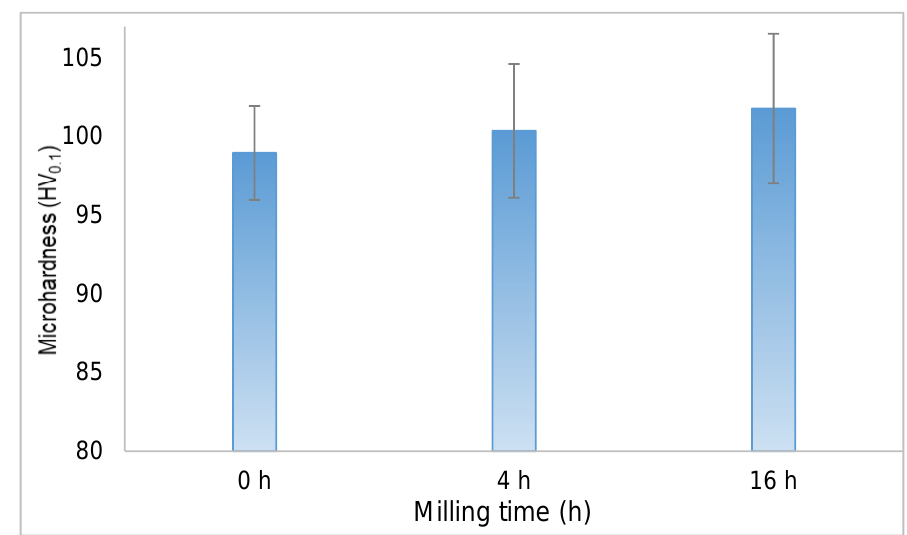
Figure 11. Microhardness test results of 0, 4 and 16 h milled powders.